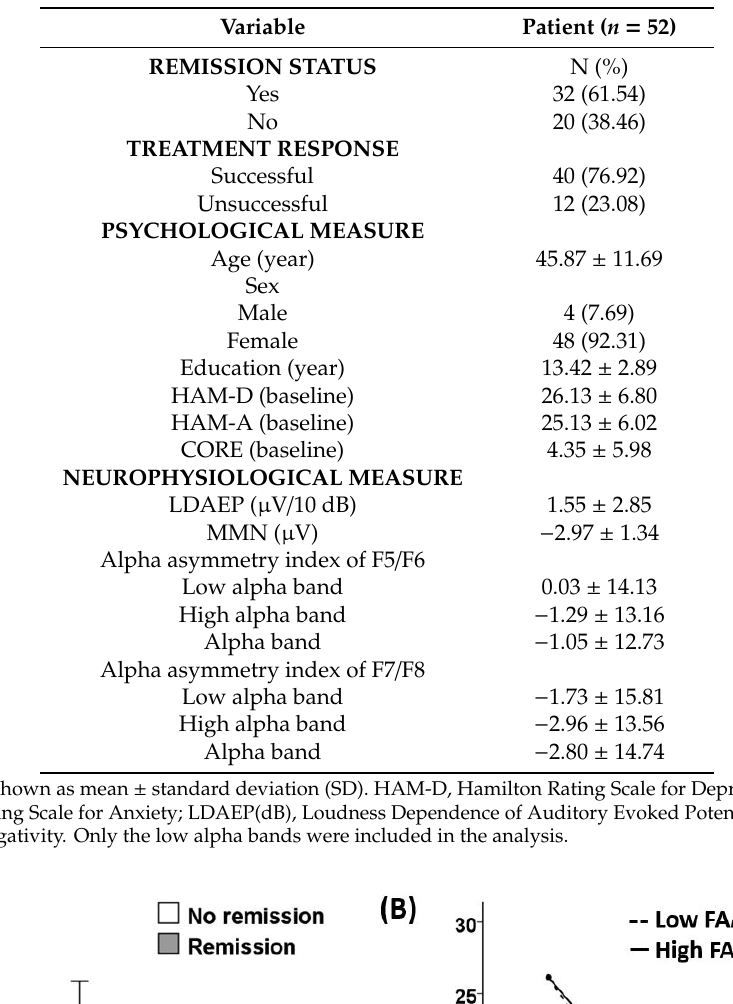
Figure 2. (A) Remission ratio by LDAEP groups (chi-square = 0.174, p = 0.676) and (B) treatment responsiveness in HAM-D score over the eight weeks by Low and High LDAEP groups (rANOVA: F (2.565, 105.182) = 1.183, p = 0.317).